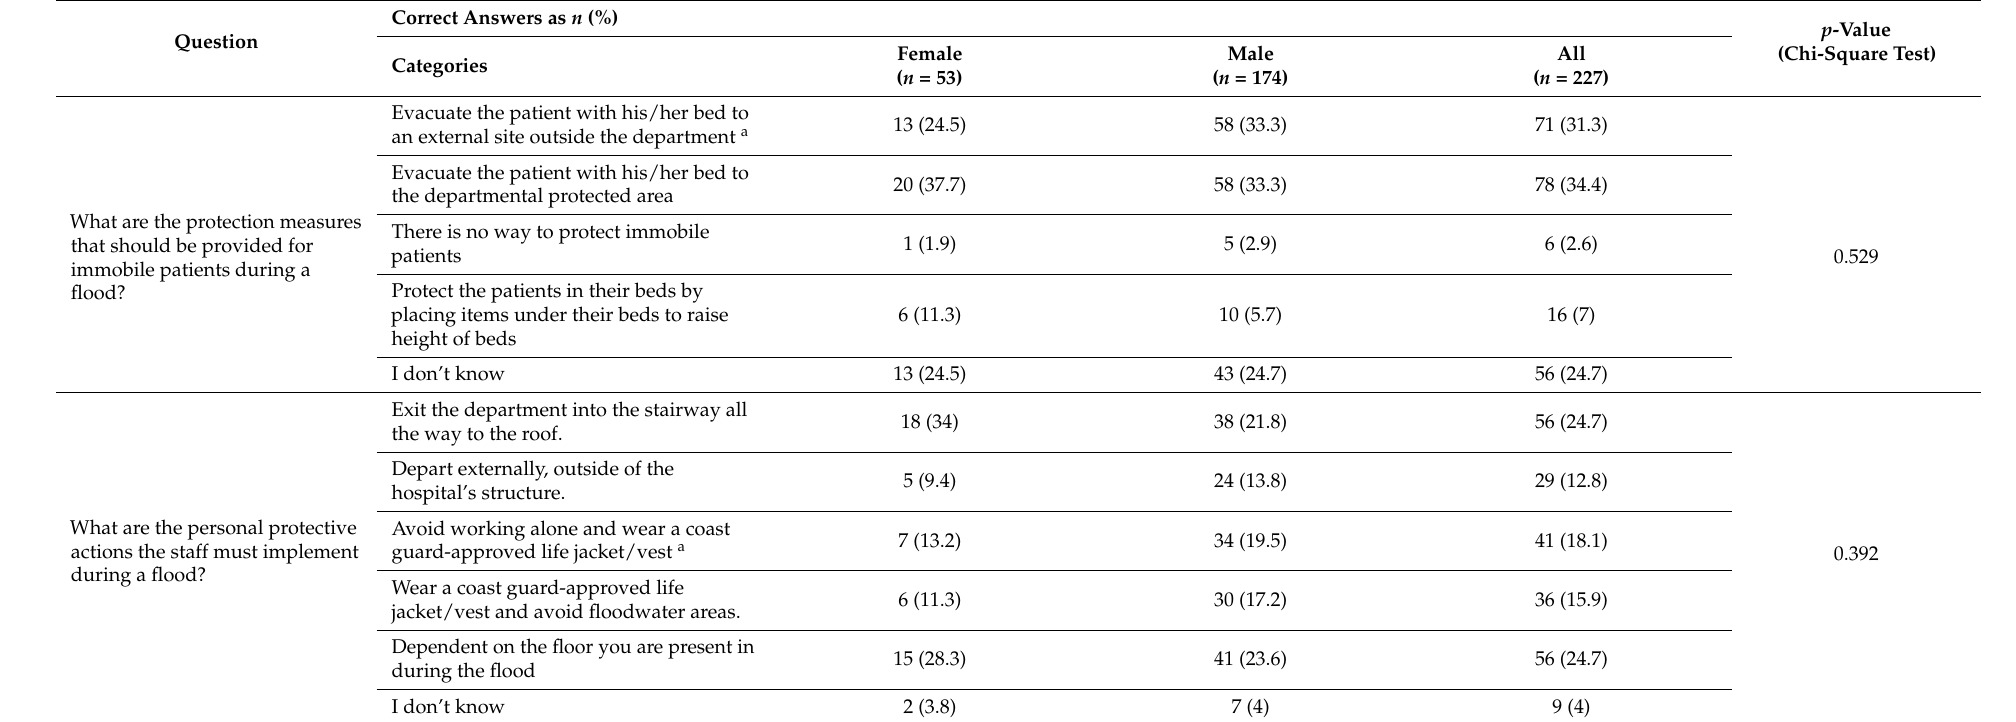
Table A1. Questions and answers regarding knowledge and competency concerning a flood